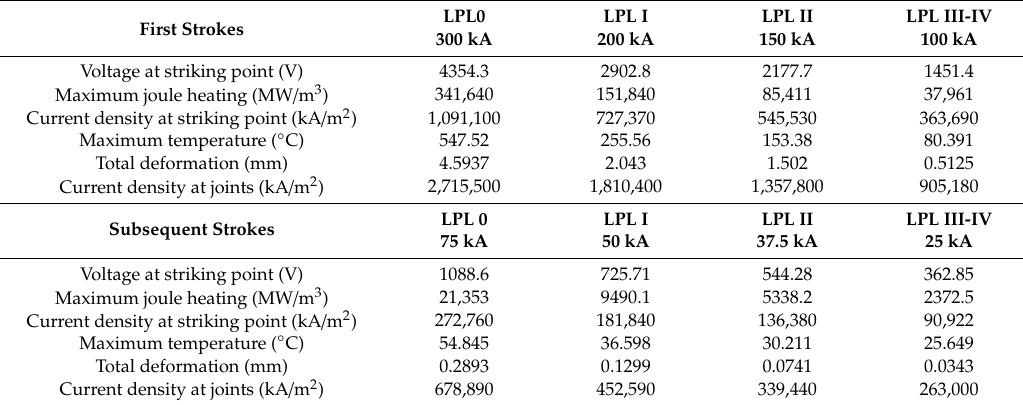
Table 5. Results obtained from the first and subsequent return strokes for Case Study D.